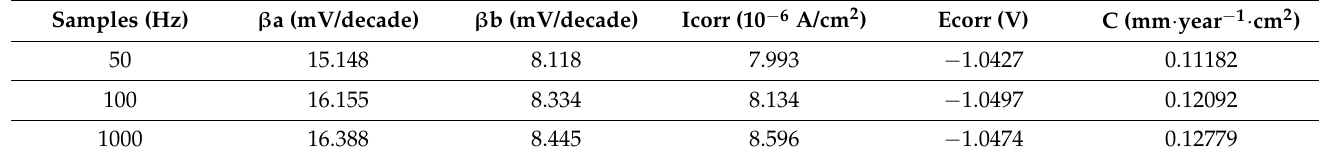
Table 2. Electrochemical parameters of zinc under 50 Hz, 100 Hz, and 1000 Hz, respectively.